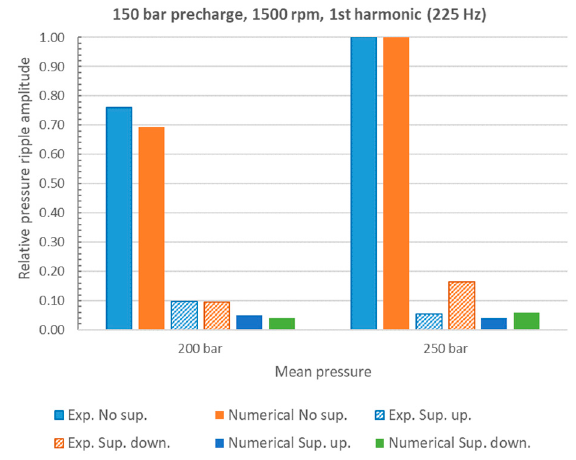
Figure 8. FFT of the pressure ripple, 2nd harmonic, pump speed = 500 rpm.